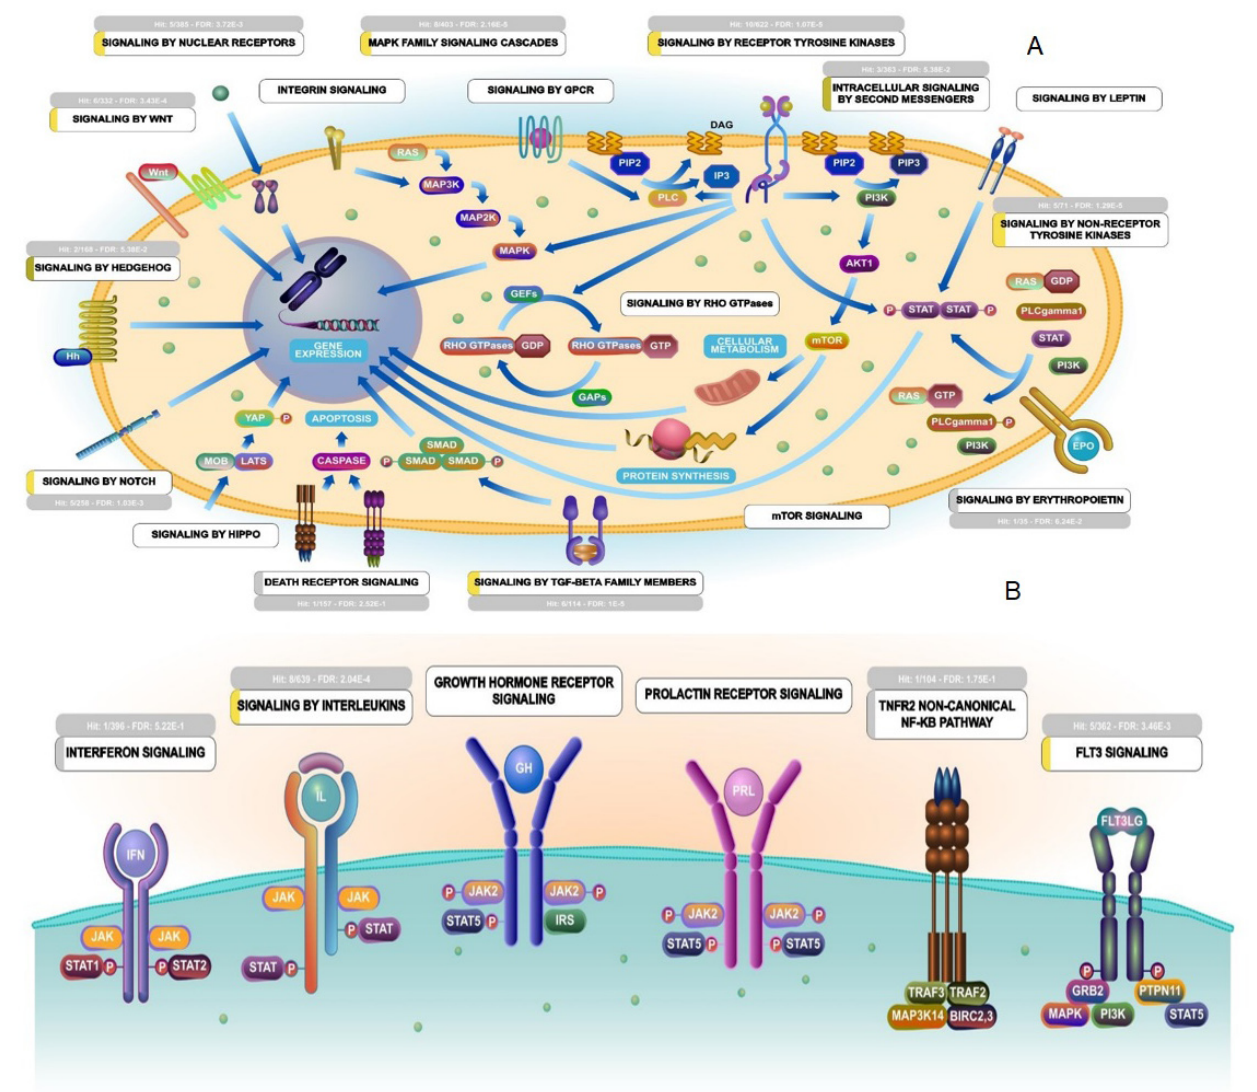
Figure 5. Pathways enrichment of Walktrap modules. ( A ) Signal transduction pathways; ( B ). Cytokine immune signaling pathways. The figures are retrieved from Reactome pathway analyzer using